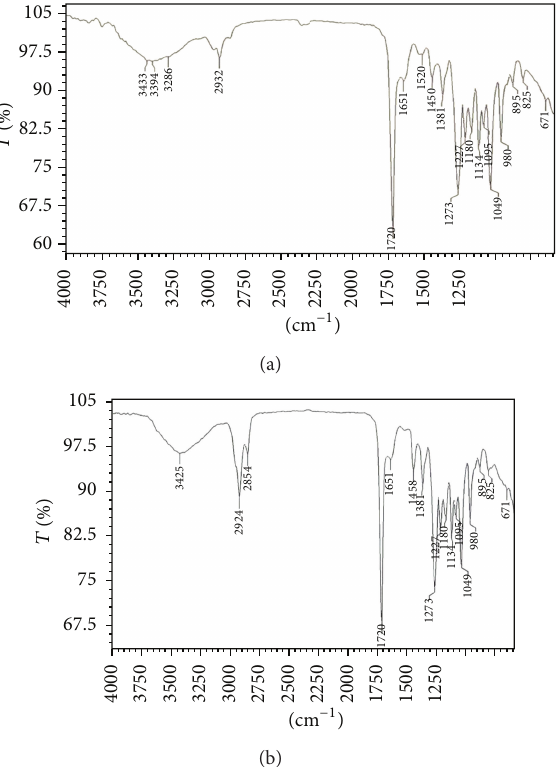
Figure 4: FTIR graph of extracted polymer of (a) NAP11 and (b) NAC1